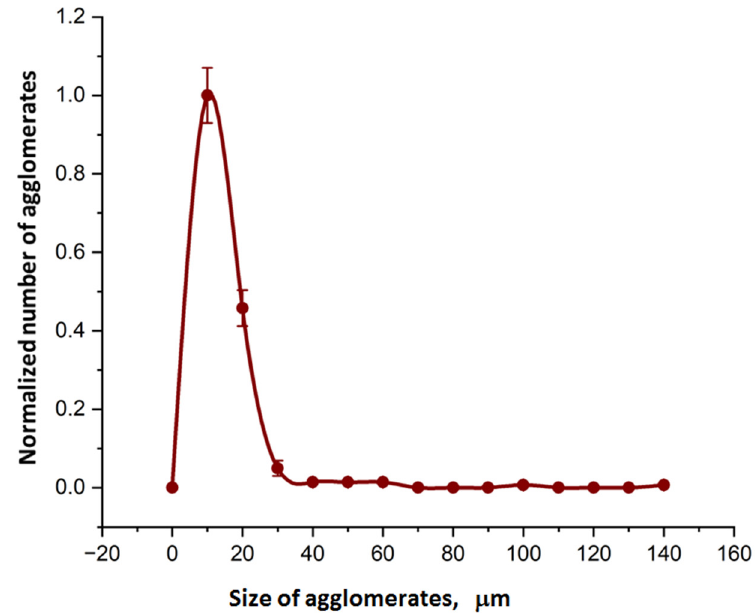
Figure 4. Agglomerates size distribution histogram for specimen 2.2.